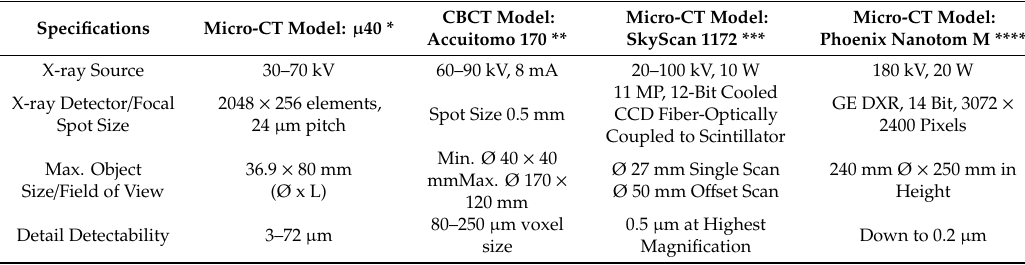
Table 1. Technical specifications of some commercial laboratory micro-CT and cone beam computed tomography (CBCT)